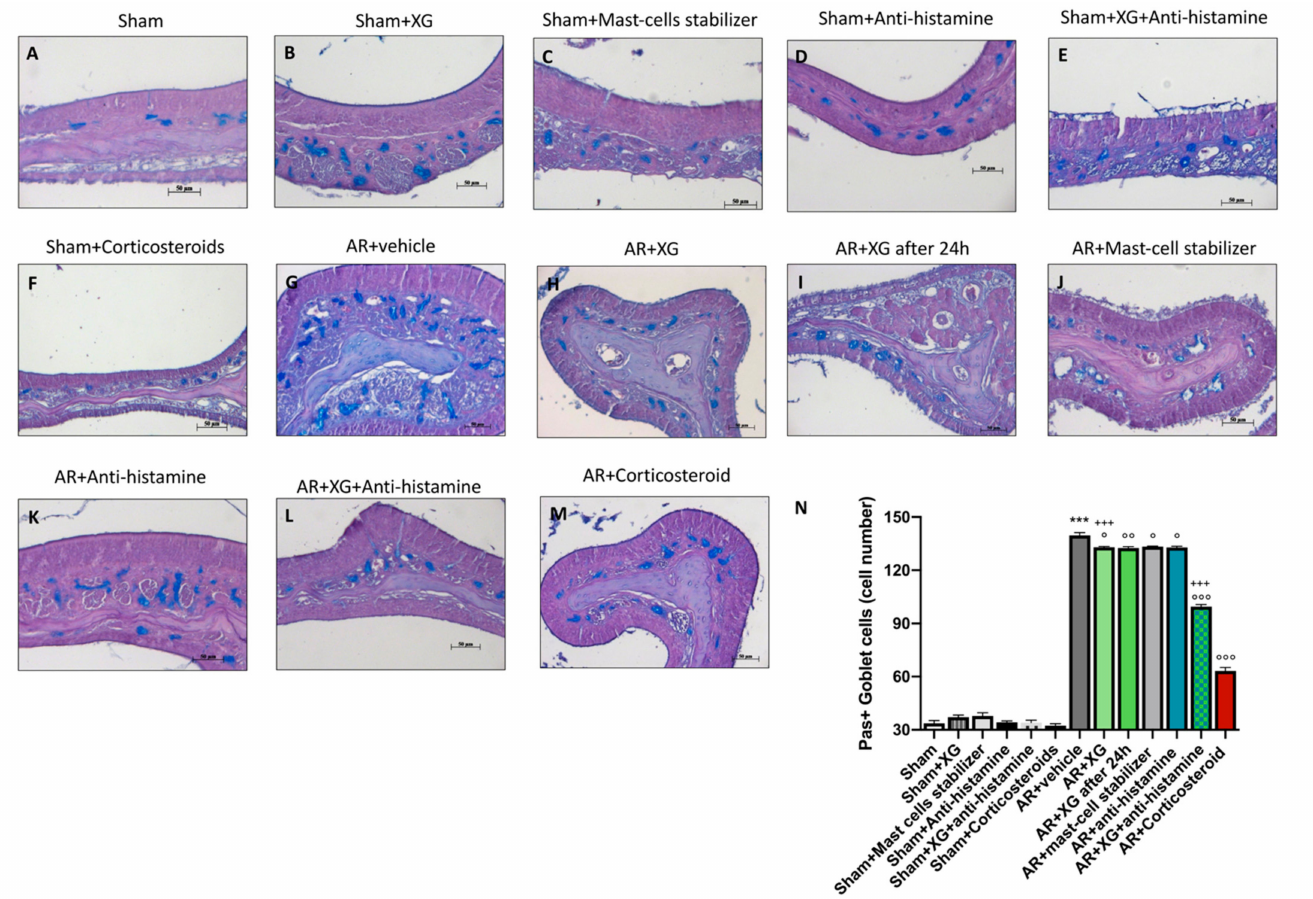
Figure 11. Effect of XG treatment on PAS staining. An important increase of PAS positive cells was detected in AR-mice ( G , histological score N ), compared to sham mice ( A – F , histological score N ). XG treatment ( H , I , histological score N ) diminished the mucous secretion observed as PAS-positive cell number with equivalent effectiveness to the antihistamine ( K , histological score N ) and mast-cell stabilizer ( J , histological score N ) treatments. In addition, co-treatment with XG and antihistamine ( L , histological score N ) reduced PAS-positive cells, in a comparable way with corticosteroid treatment ( M , histological score N ). Data are representative of at least three independent experiments. Values are means ± SEM. One-Way ANOVA test. *** p < 0.001 vs. Sham; ◦ p < 0.05 vs. AR + vehicle; ◦◦ p < 0.01 vs. AR + vehicle; ◦◦◦ p < 0.001 vs. AR + vehicle; +++ p 0.001 vs. AR +